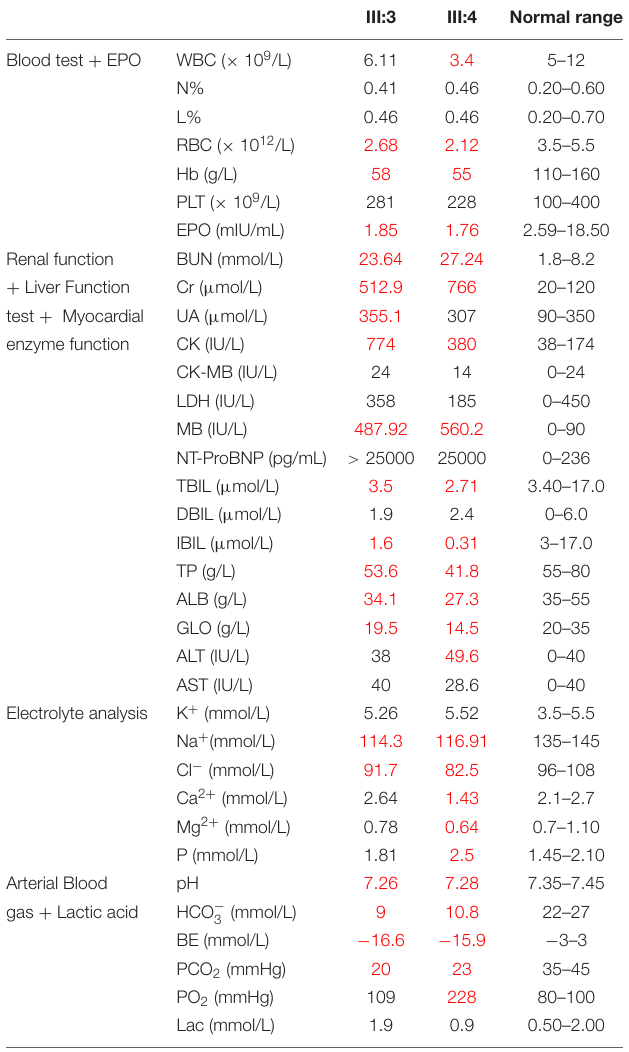
TABLE 1 | Biochemical features of two patients with infantile form of primary hyperoxaluria type 1.